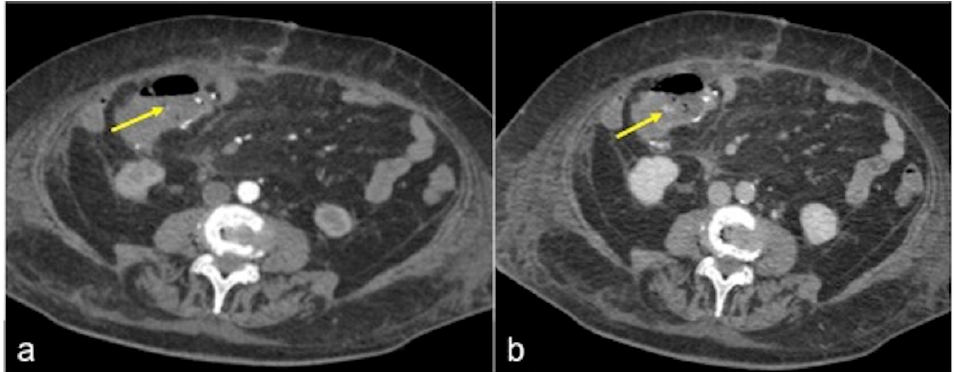
Figure 15. CTA multiphasic study of slow flow bleeding in arterial ( a ) and venous ( b ) phases. The haemorrhagic spot at the surgical site of ileo-colic anastomosis appears inconspicuous in the arterial phase (( a ) arrow) and is better identifiable in the venous phase (( b ) arrow).